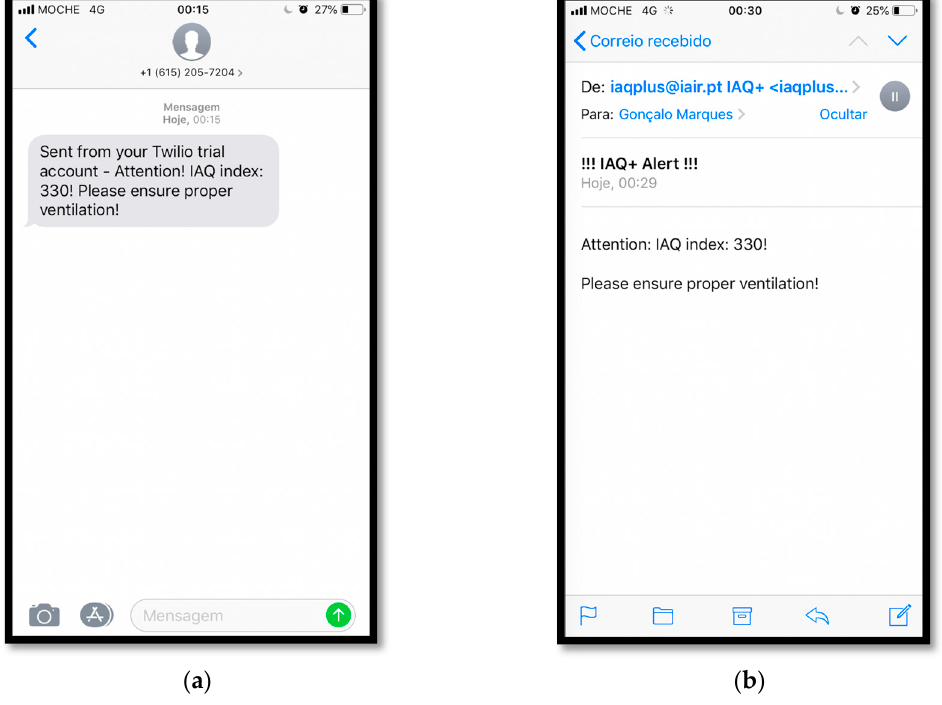
Figure 8. Examples of SMS ( a ) and E-mail ( b ) notifications.